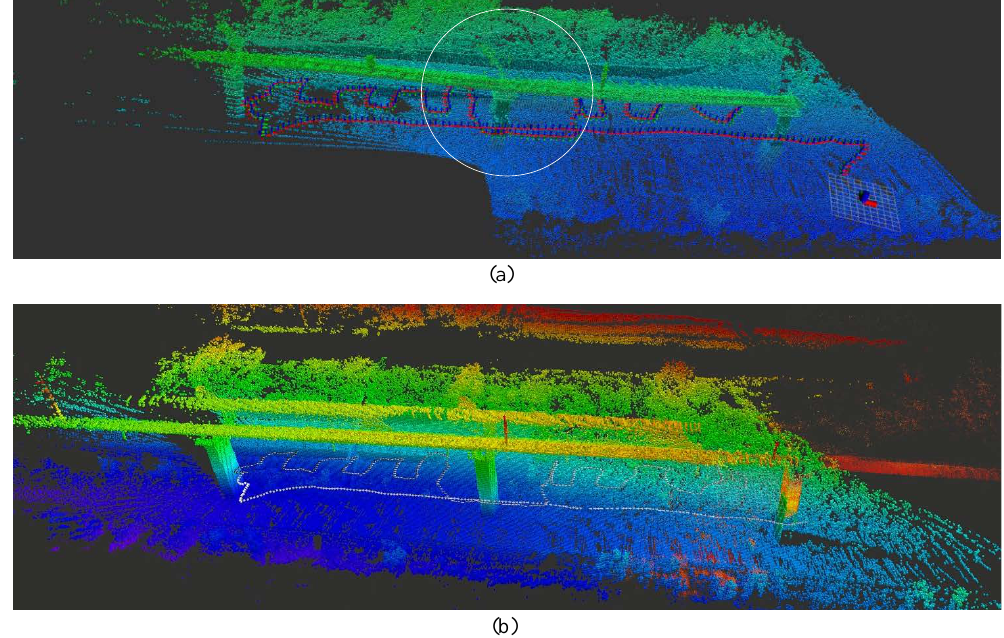
Figure 7. Comparison of mapping results with different node generation methods. ( a ) Mapping result with VI odometry only. ( b ) Mapping result with VI and NDT-based odometry. The white circle in ( a ) indicates the region where the bottom of the bridge and the column appear curved because of drift error, whereas ( b ) shows more accurate mapping results than ( a ) for the 3D map of the straight